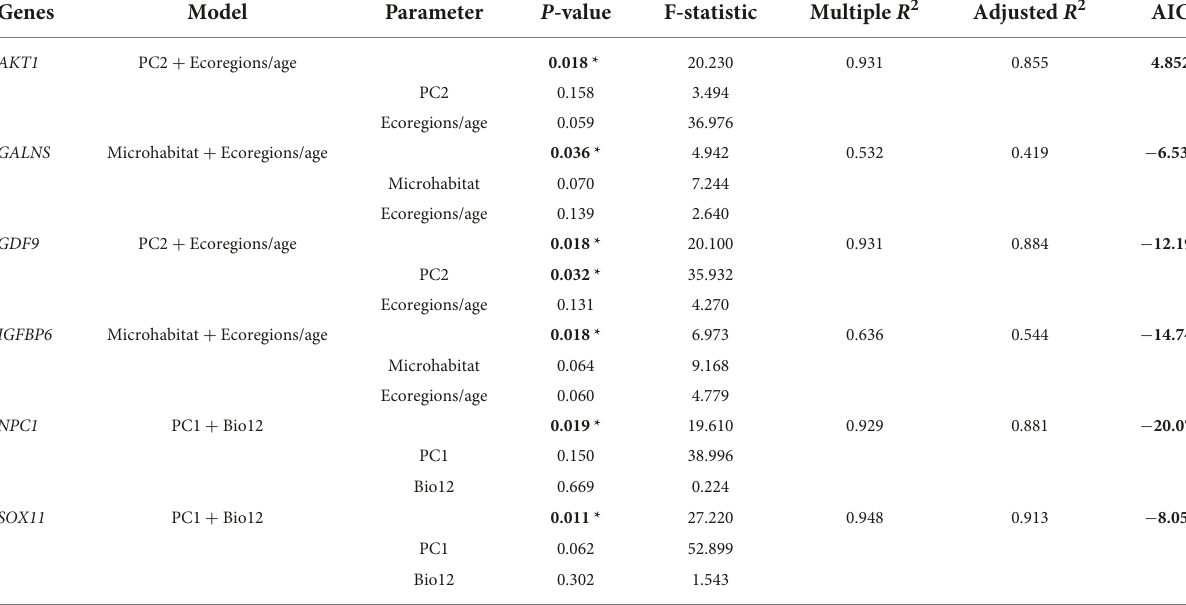
TABLE 5 Multiple regression analyses of the relationships between gene evolution and ecological factors in lizards.